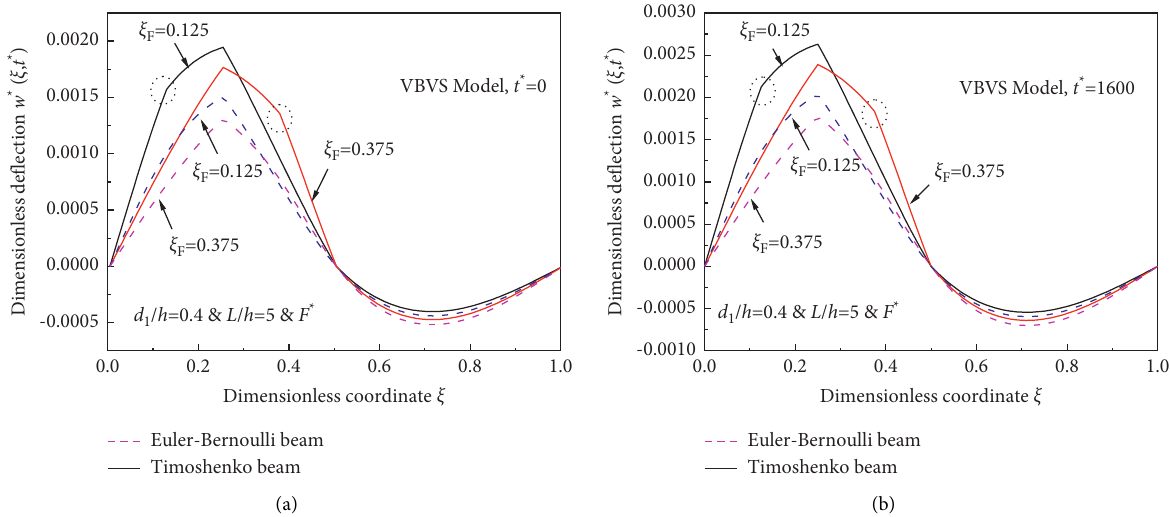
Figure 15: (a) Distribution of dimensionless deflection w ∗ ( ξ , t ∗ ) versus dimensionless coordinate ξ of the continuous cracked beams with VBVS model when t ∗ � 0. (b) Distribution of dimensionless deflection w ∗ ( ξ , t ∗ ) versus dimensionless coordinate ξ of the continuous cracked beams with VBVS model when t ∗ �